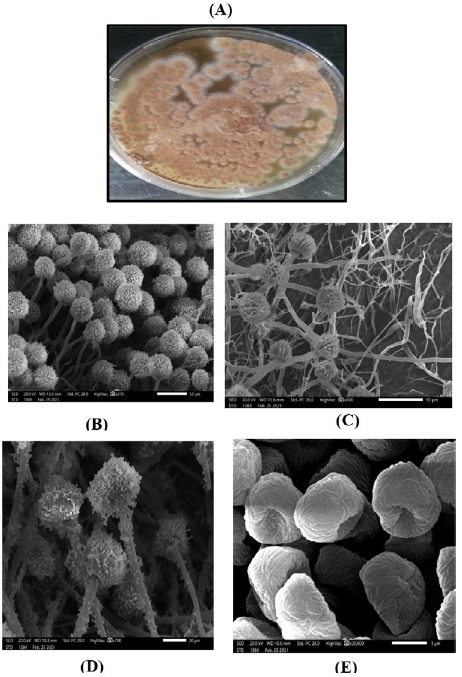
Fig. 3. Colony morphology of Aspergillus terreus SHE05 on potato dextrose agar medium (A) and electron microscopic photographs of Aspergillus terreus SHE05 using magnification of 370x (B), 500 x (C), 700 x (D), 20000x (E).